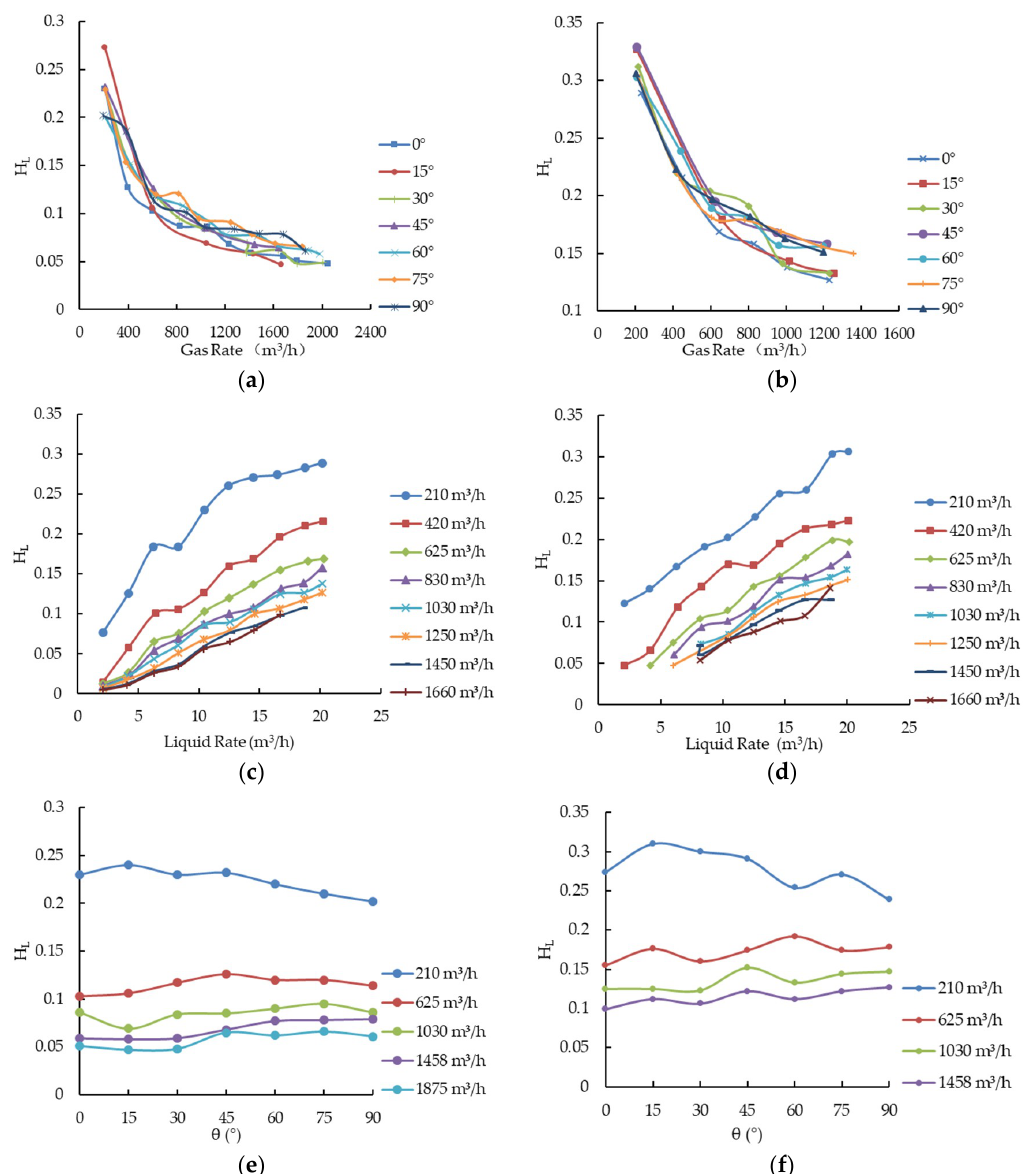
Figure 3. Analysis of influencing factors of liquid holdup: ( a ) when liquid rate is10.40 m 3 /h, the law of liquid holding rate with inclination angle and gas flow rate; ( b ) when liquid rate is 20.83 m 3 /h, the law of liquid holding rate with inclination angle and gas flow rate; ( c ) when inclined angle is 0°, the law of liquid holding rate with liquid and gas flow rate; ( d ) when inclined angle is 90°, the law of liquid holding rate with liquid and gas flow rate; ( e ) when liquid rate is 10.40 m 3 /h, the law of liquid holding rate with inclination angle; ( f ) when liquid rate is 16.67 m 3 /h, the law of liquid holding rate with inclination angle.